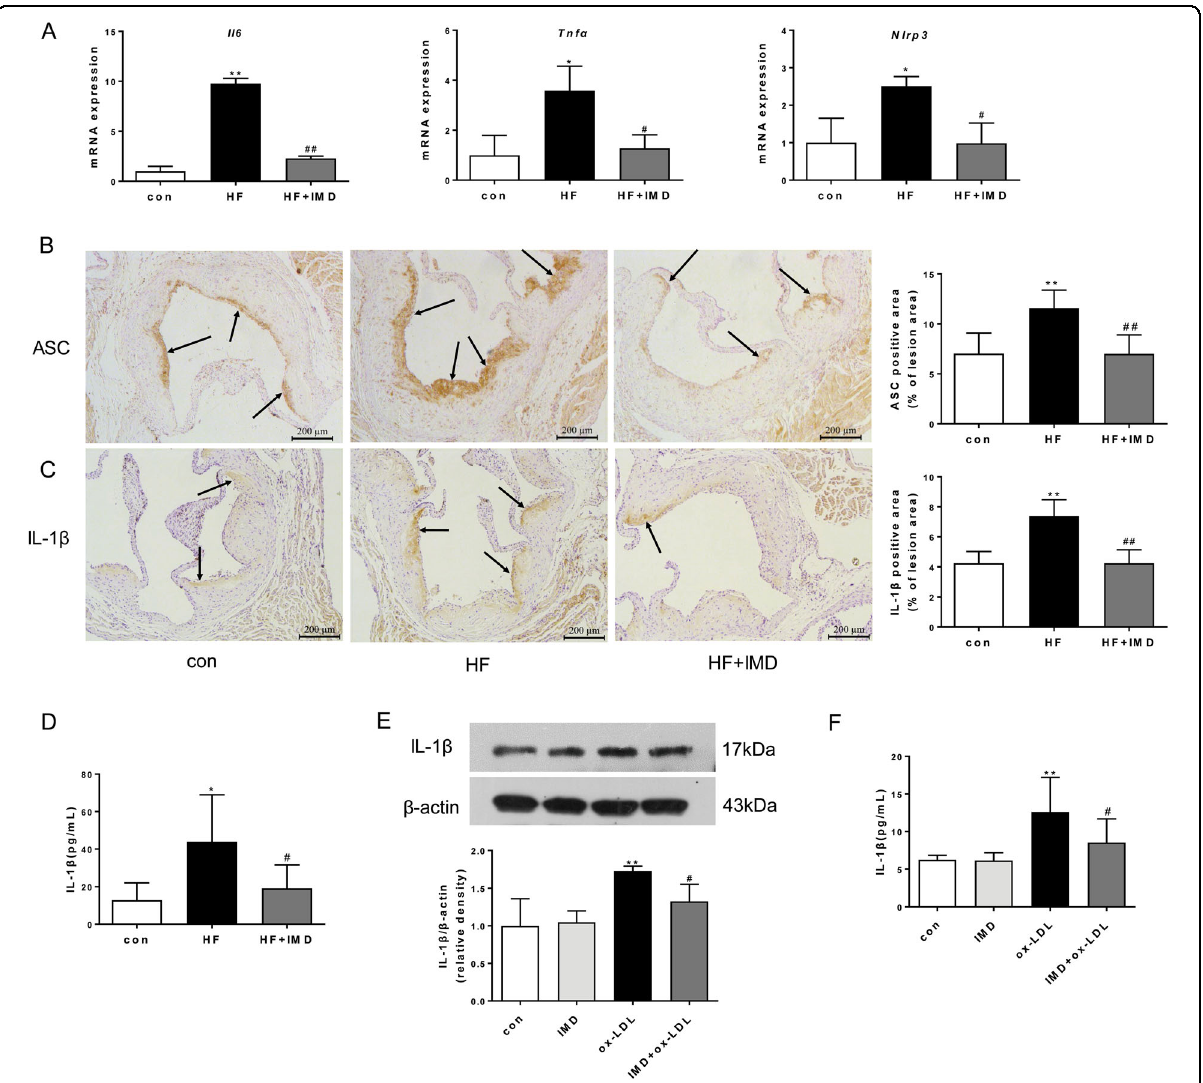
Fig. 6 IMD 1-53 inhibited apoptosis-triggered in fl ammasome in advanced lesional macrophage. A – C Eight-week-old male ApoE − / − were fed a standard chow diet (con) or a high-fat diet (HFD) for 16 weeks. After 10 weeks of HFD feeding, ApoE – / – mice received either PBS or intermedin 1-53 (IMD 1-53 ) during the left 6 weeks of high-fat diet feeding. Quantitative real-time PCR of interleukin6 ( IL6 ), tumor necrosis factor α ( Tnf α ), and Nlrp3 mRNA expression ( A ). Results are relative to the GAPDH level ( n = 3). Representative images and quanti fi cation data of apoptosis-associated speck- like protein containing CARD (ASC) ( B ) and IL-1 β ( C ) immunohistochemical staining at the aortic root of mice from con, HF, and HF + IMD. Black arrows indicate the area stained positively for ASC or IL-1 β . Scale bars, 200 μ m. n = 6. D Plasma IL-1 β level was measured. n = 6. Data are mean ± SD. * P < 0.05 and ** P < 0.01 compared with con, # P < 0.05 and ## P < 0 . 01 compared with HF group; one-way ANOVA. E Western blot analysis of protein expression of IL-1 β in macrophages treated with PBS, IMD 1-53 , ox-LDL and IMD 1-53 + ox-LDL. β -actin was a control for protein loading. Results are representative of four experiments. Densitometric analysis of protein levels is shown as a ratio to β -actin. n = 4. F IL-1 β in the cell culture supernatant was also measured. n = 5. Data are mean ± SD. ** P < 0.01 compared with con, # P < 0.05 compared with the ox-LDL group; one-way